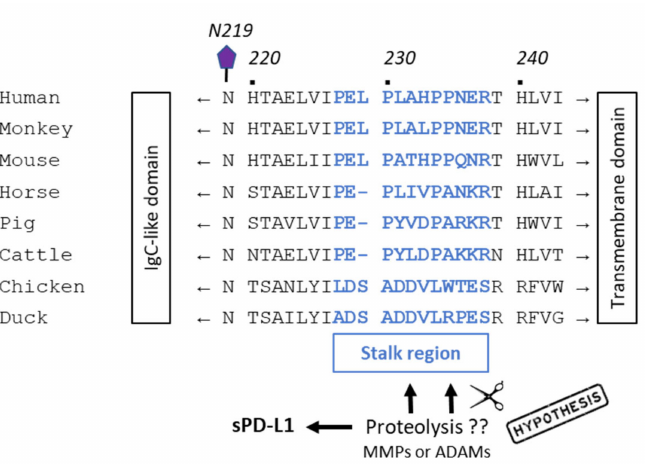
Figure 4. Alignment of amino acid sequences of PD-L1 from humans with other species. A stalk region of 10–12 amino acids (in bold blue) is located between the IgC-like domain and the transmem- brane domain. This region would correspond to the site of cleavage of mPD-L1 by proteases, MMPs and/or ADAMs, to release sPD-L1 [83]. Amino acid sequences were derived from